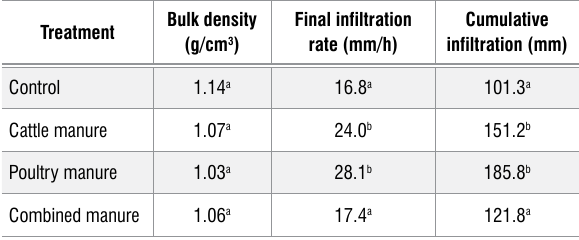
Effect of organic manure on surface soil physical properties